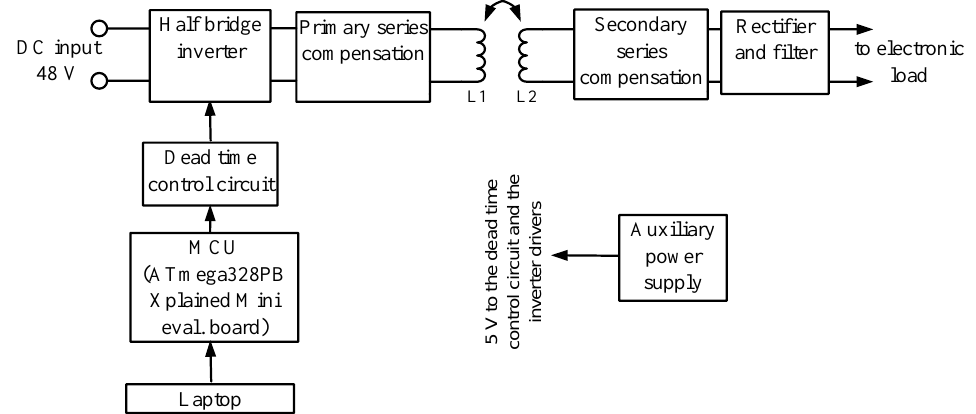
Figure 8. A block diagram of the experimental prototype. Table 1. The parameters values of the designed WPT